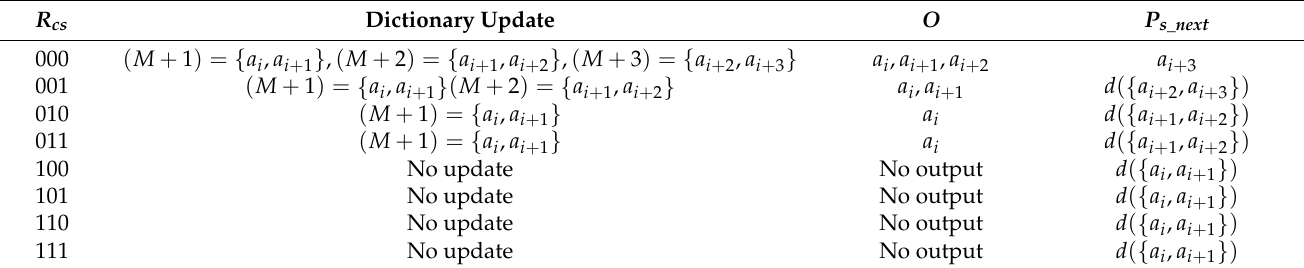
Table 1. The coding principle and dictionary update of the CS-based LZW